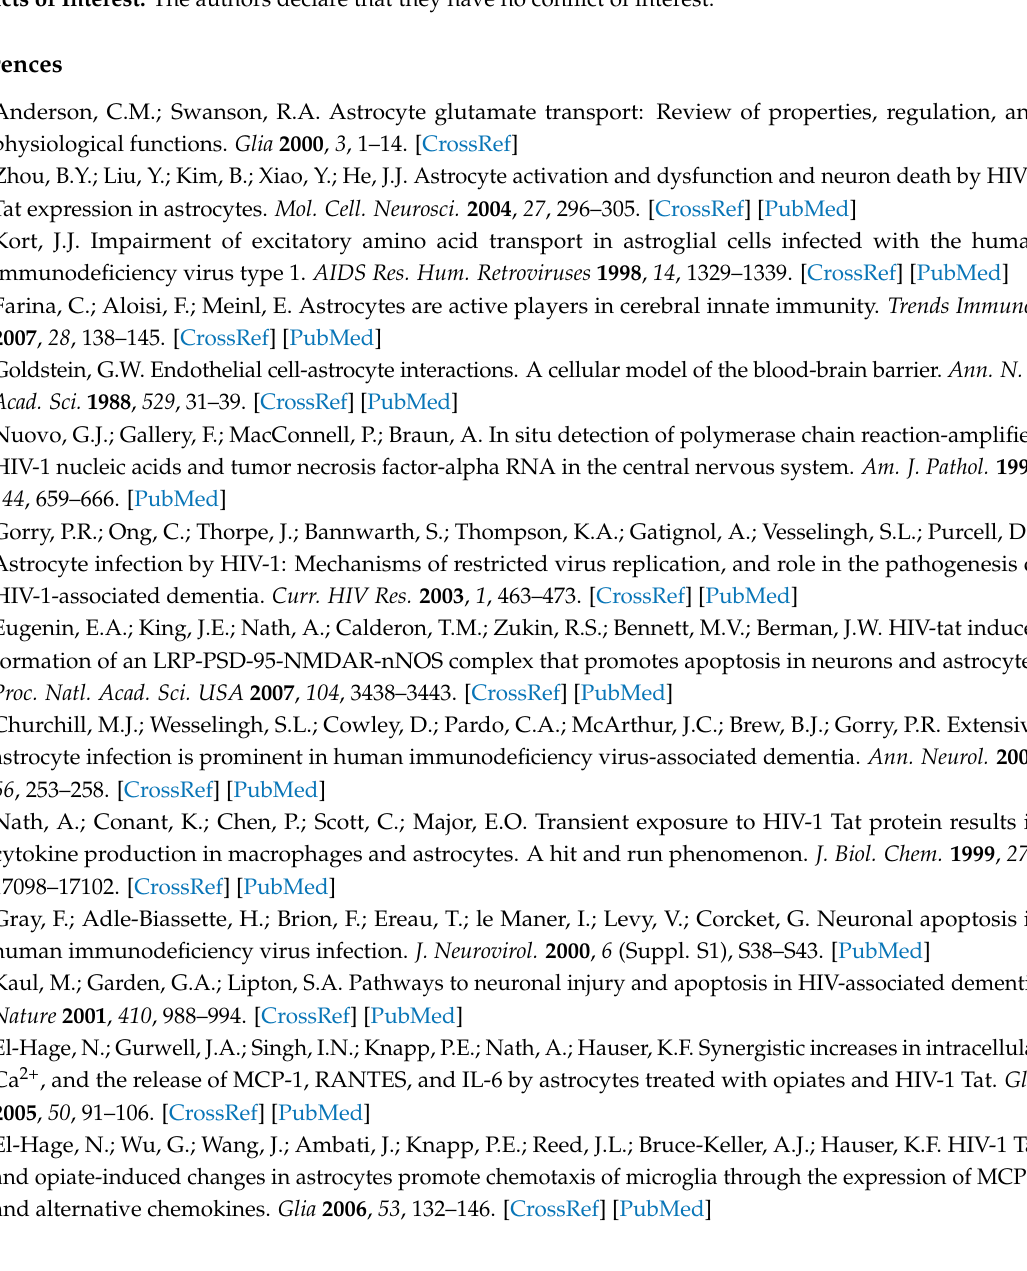
Figure S1: Activation of the Autophagy pathway following gene silencing and pharmacological inducer, Figure S2: Effect of morphine on Beclin1 expression and inflammation in human astrocytes, Table S1: Treatment with rapamycin and transfection with siBeclin1 modulate cell survival-related